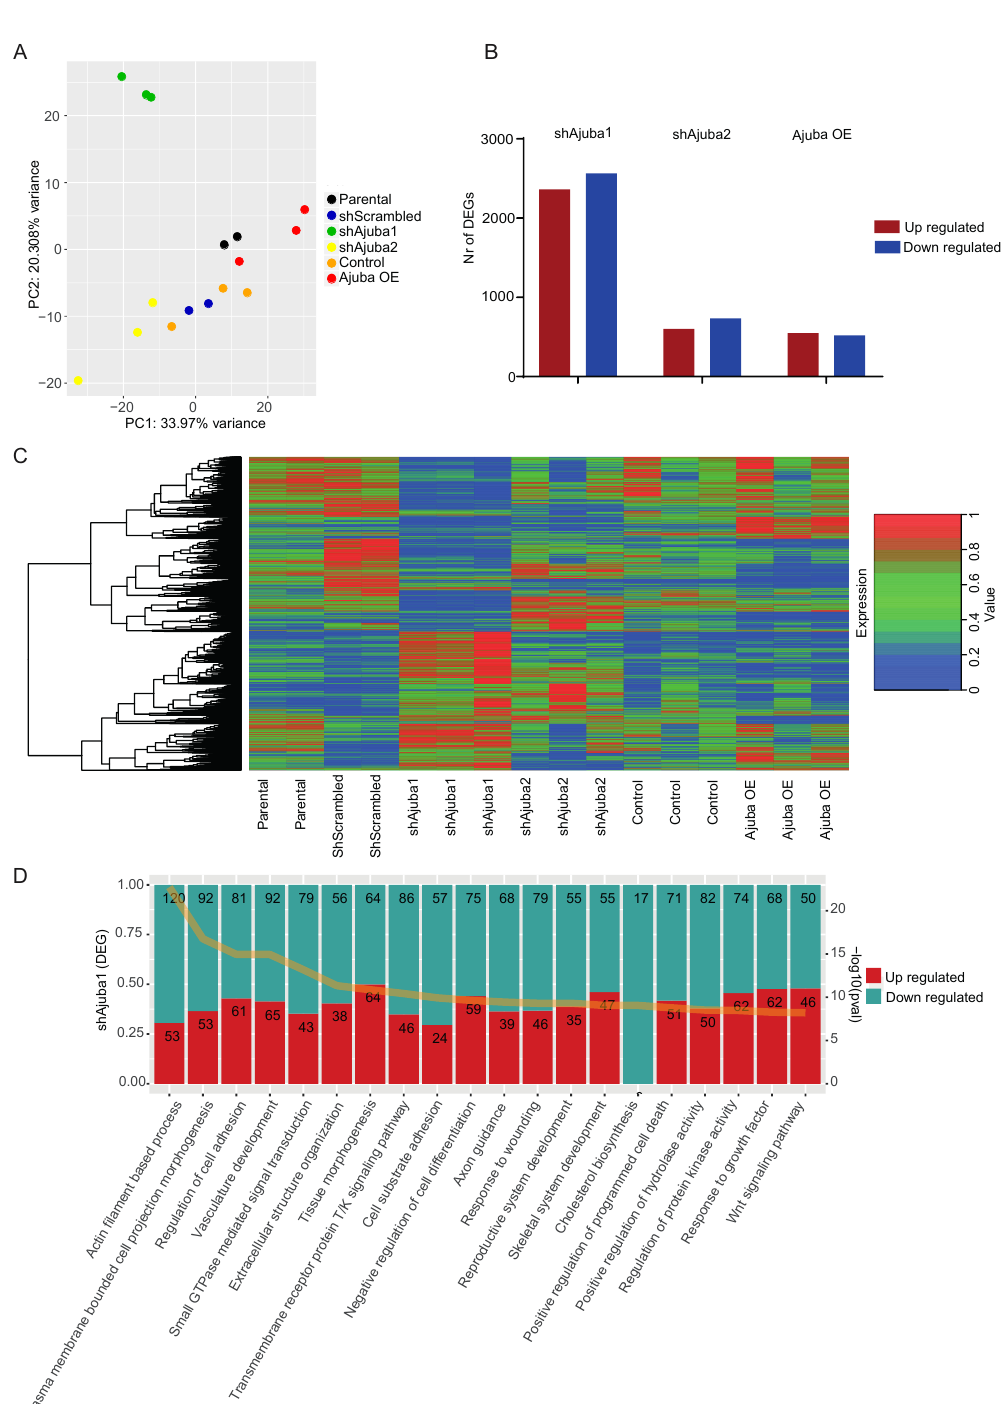
Figure 3. RNA-seq analysis shows most DEGs between shAjuba1 and its control. ( A ) Principle component analysis of RNA-sequencing of all conditions of SW480 colon cancer cell lines. ( B ) Number of di ff erentially expressed genes that are up or down regulated between the di ff erent samples and their respective control (shAjuba1 and shAjuba2 compared with shScrambled and Ajuba OE compared with control). ( C ) Heat map of expression level of all significantly di ff erentially expressed genes. ( D ) Pathway enrichment analysis of significantly di ff erentially expressed genes between ShAjuba1 and its shScrambled control using Metascape analysis. The yellow line across the figure represents the calculated p